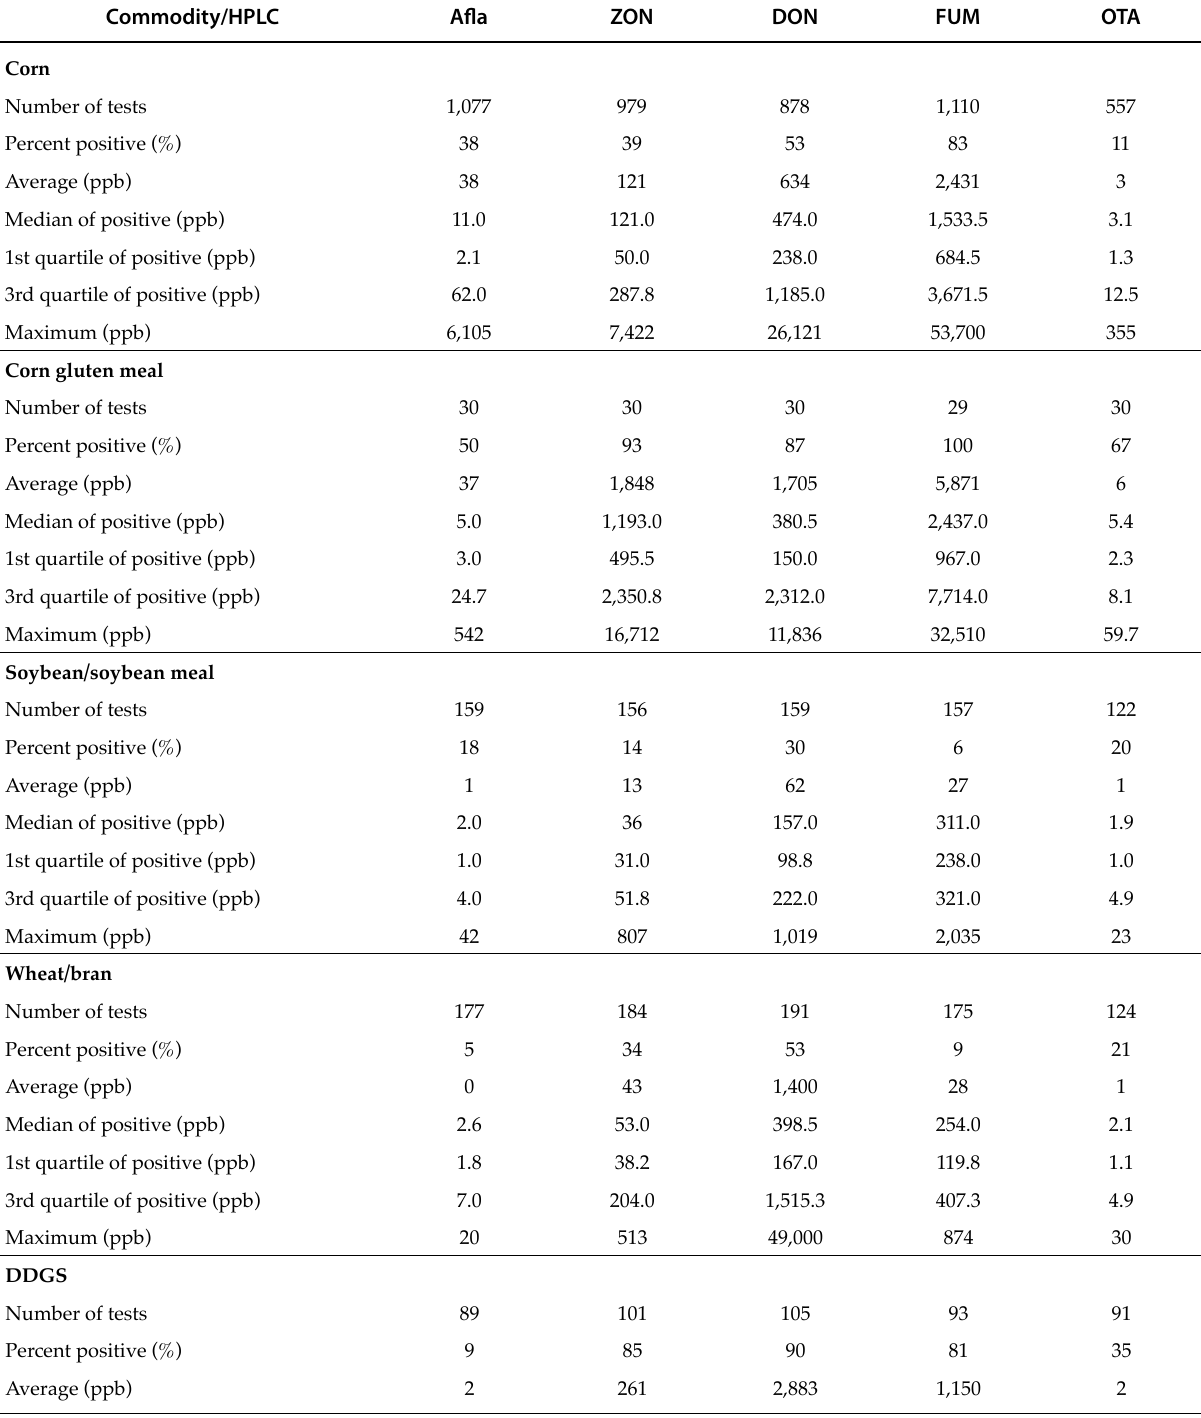
Table 7b. Survey results by commodity, determined by HPLC. Commodity/HPLC Afla ZON DON FUM OTA